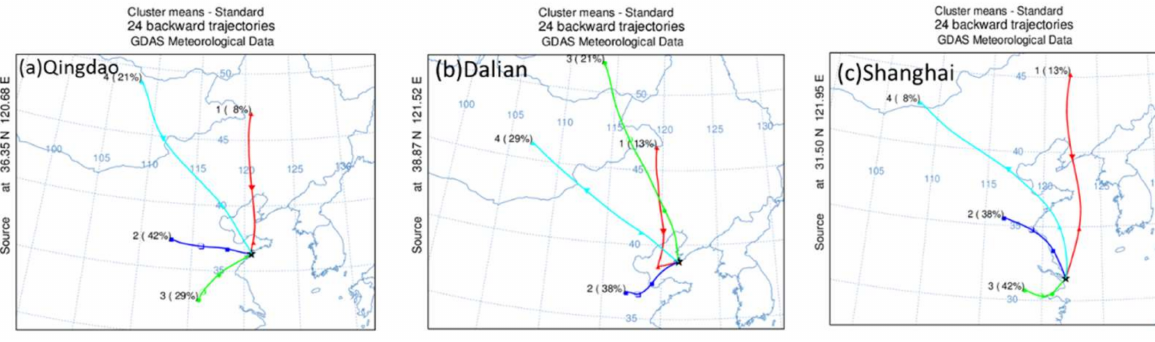
Figure 13. The 24 h backward trajectory of wind fields in Qingdao ( a ), Dalian ( b ) and Shanghai ( c ) from 6 December 2019 to 11 December